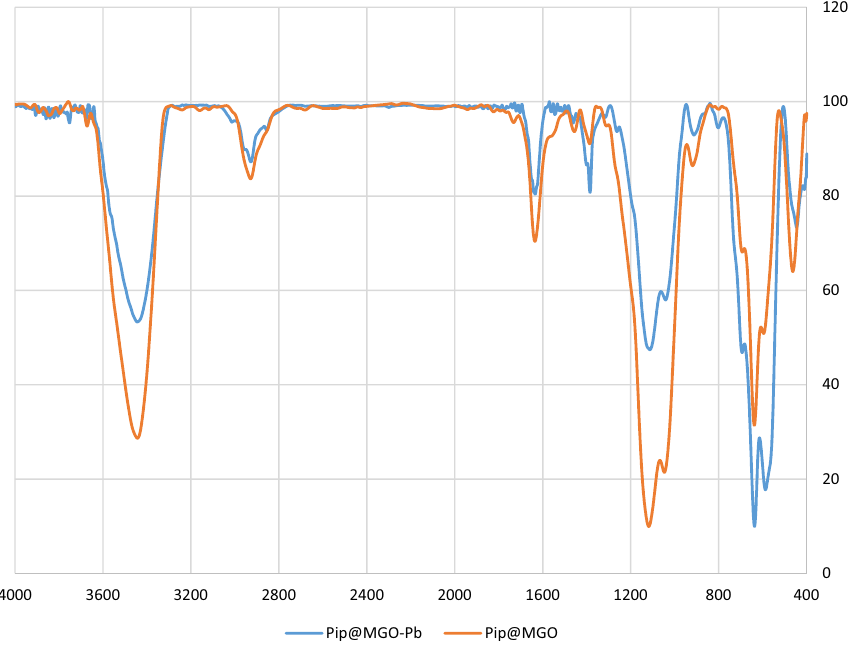
Figure 2. FT-IR spectrum of Pip@MGO and Pip@MGO-Pb